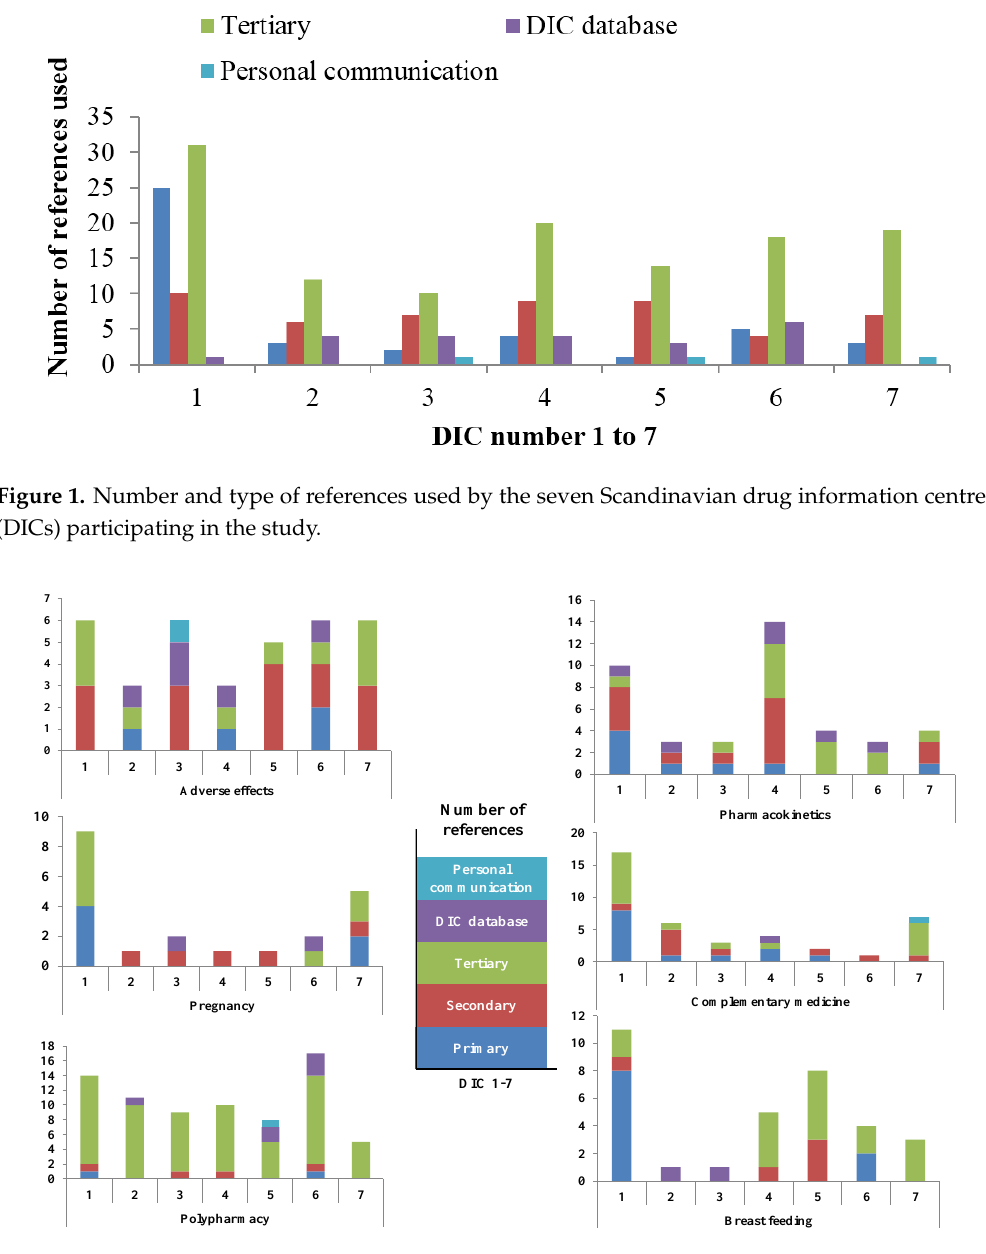
Figure 2. Type of references related to type of query for the seven Scandinavian drug information centres (DICs) participating in the study. Note that the ordinates are displayed with different scales.